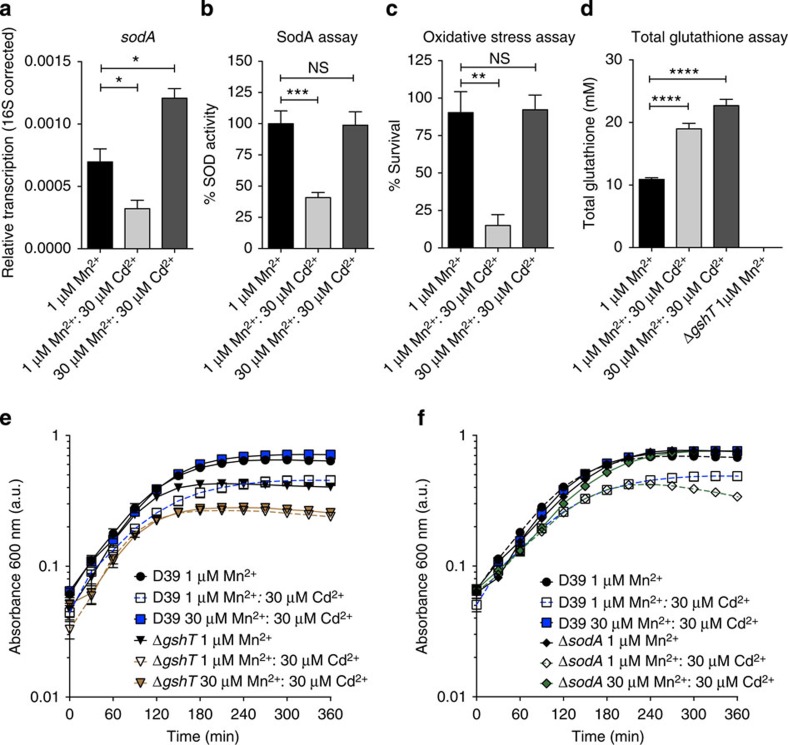
The impact of Cd2+ on sensitivity to oxidative stress.(a) Relative transcription, corrected to 16S rRNA, of sodA by S. pneumoniae when grown in CDM supplemented with 1 μM Mn2+ (black), 1 μM Mn2+: 30 μM Cd2+ (light grey) and 30 μM Mn2+: 30 μM Cd2+ (dark grey). The data correspond to the mean (±s.e.m.) of three independent biological experiments. (b) SodA activity assay S. pneumoniae when grown in CDM supplemented with 1 μM Mn2+ (black), 1 μM Mn2+: 30 μM Cd2+ (light grey) and 30 μM Mn2+: 30 μM Cd2+ (dark grey). Activity was calculated as a percentage of SodA activity observed for S. pneumoniae cells grown in 1 μM Mn2+. The data correspond to the mean (±s.e.m.) of three independent biological experiments. (c) Paraquat killing of S. pneumoniae grown in CDM supplemented with 1 μM Mn2+ (black), 1 μM Mn2+: 30 μM Cd2+ (light grey) and 30 μM Mn2+: 30 μM Cd2+ (dark grey). Survival was calculated as a percentage of colonies at 30 min compared with cells not challenged with paraquat. The data correspond to the mean (±s.e.m.) of three independent biological experiments. (d) Total glutathione determination per mean cell volume for S. pneumoniae grown in CDM supplemented with 1 μM Mn2+ (black), 1 μM Mn2+: 30 μM Cd2+ (light grey) and 30 μM Mn2+: 30 μM Cd2+ (dark grey). The statistical significance of the differences in the mean data for a–d was determined by two-tailed unpaired t-tests (NS, not significant; *P<0.05, **P<0.01, ***P<0.001, ****P<0.0001). (e,f) S. pneumoniae ΔgshT (e) and ΔsodA (f) grown in CDM supplemented with metal ions as indicated. The data correspond to mean (±s.e.m.) absorbance 600 nm measurements from three independent biological experiments. Errors bars, where not visible, are overlapped by the representative symbols.